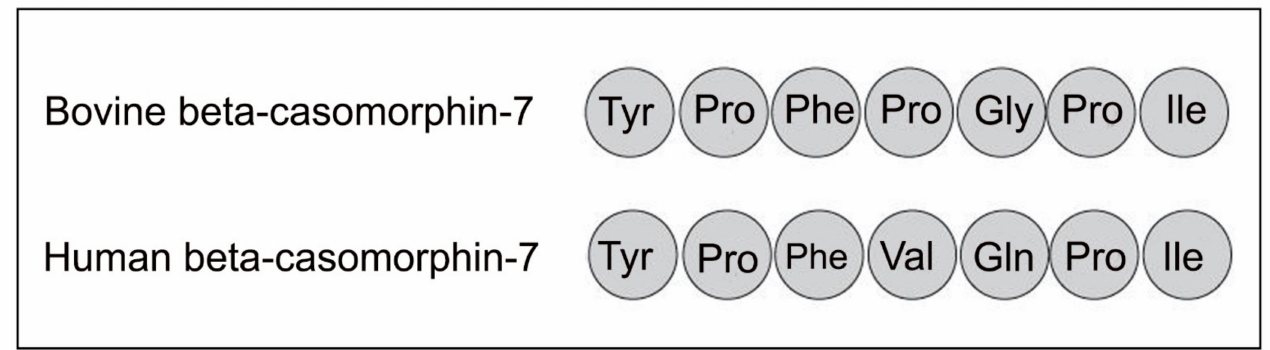
Figure 2. Comparing human and bovine